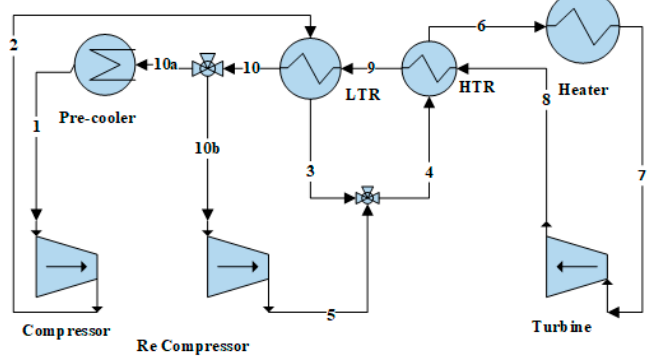
Figure 1. The layout of the sCO 2 -BC cycle.